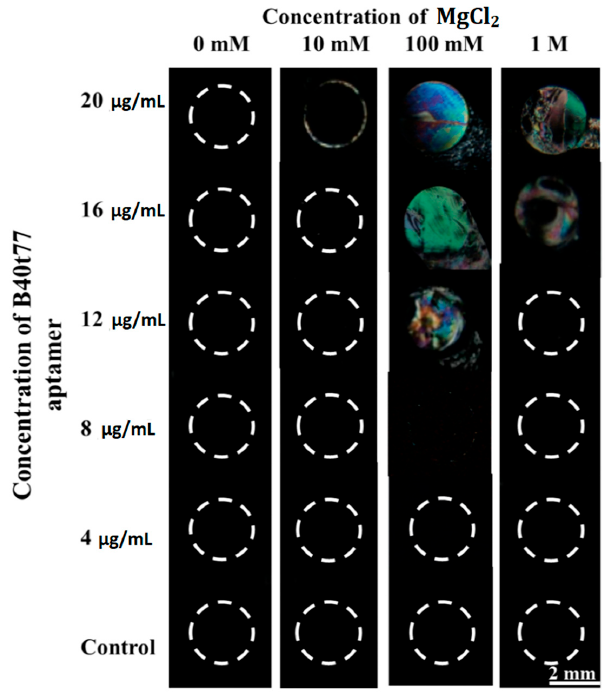
Figure 2. Optical images of LCs supported on DMOAP-coated surface immobilized with B40t77